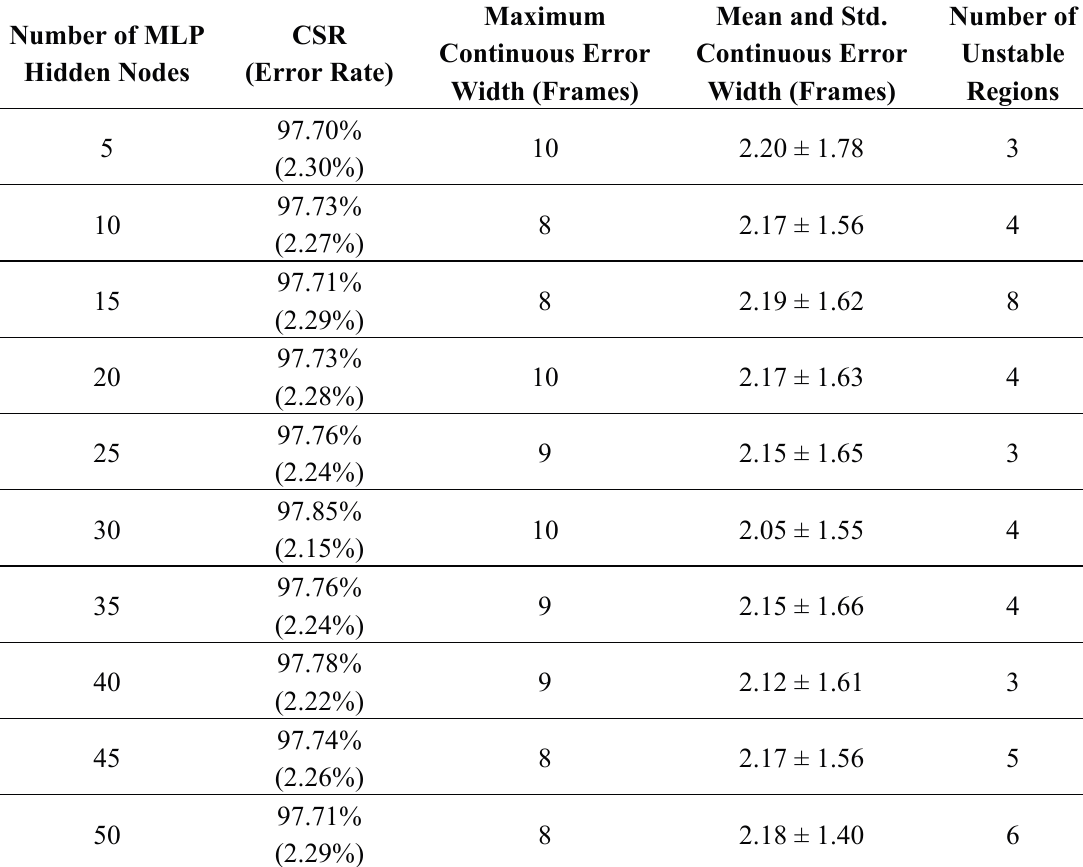
Table 2. Offline classification results of walking phase classifiers with MLP